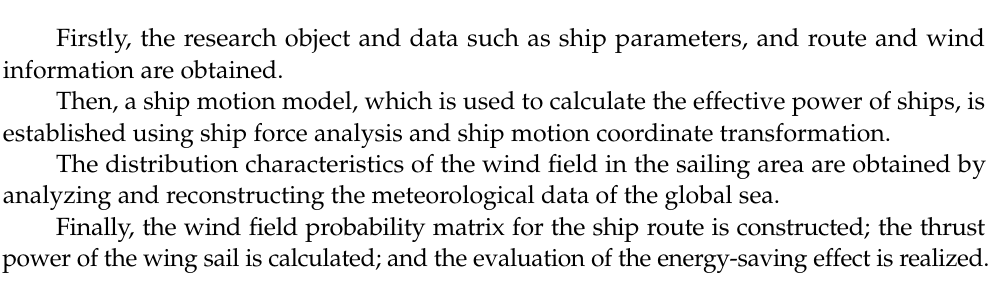
Figure 7. Energy-saving evaluation process of wing sail-assisted ships.